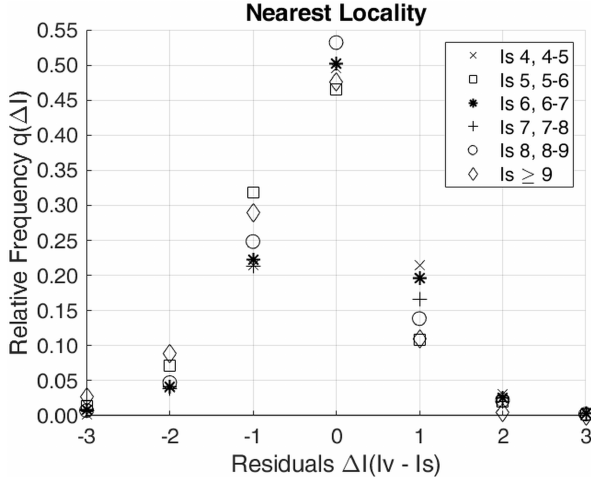
Figure 2. Frequencies of selected intensity values related to the 546 earthquakes used in the analysis. Figure 3. Relative frequency of q((cid:49)I) as a function of intensity I s for the nearest locality within